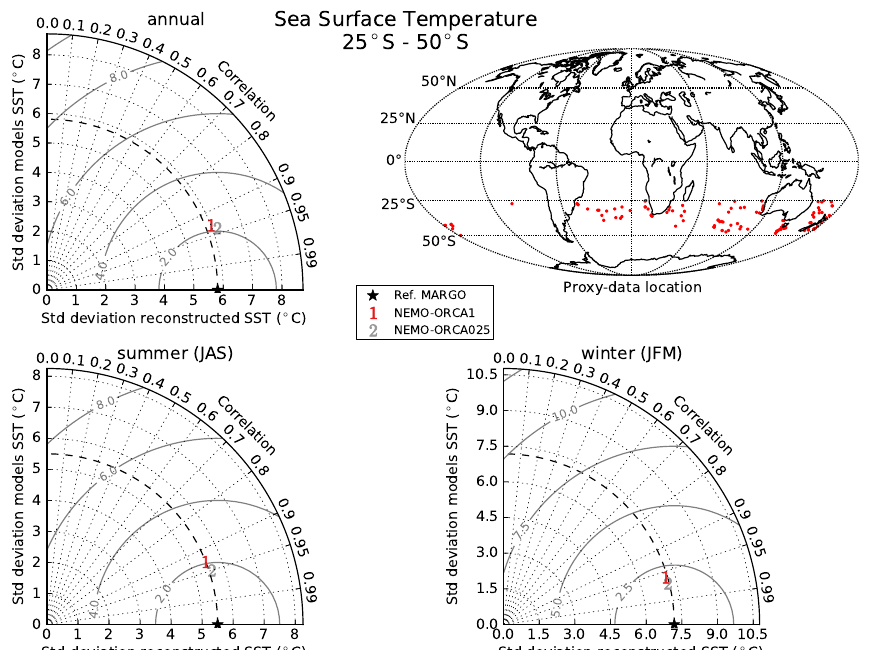
Fig. 12. Taylor diagrams summarizing the correlation coefficient, the standard deviations and RMSE for the LGM annual, boreal winter (JFM) and boreal summer (JAS) modelled and reconstructed sea surface temperatures between 25 and 50 ◦ S. The proxy-data locations are shown in the upper right-hand diagram. The NEMO-ORCA1 is symbolized with the number 1, NEMO-ORCA025 with the symbol